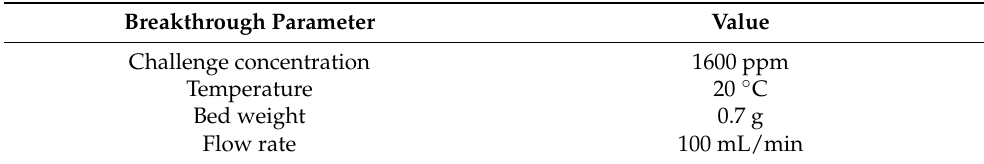
Table 5. Cyanogen chloride breakthrough test parameters.